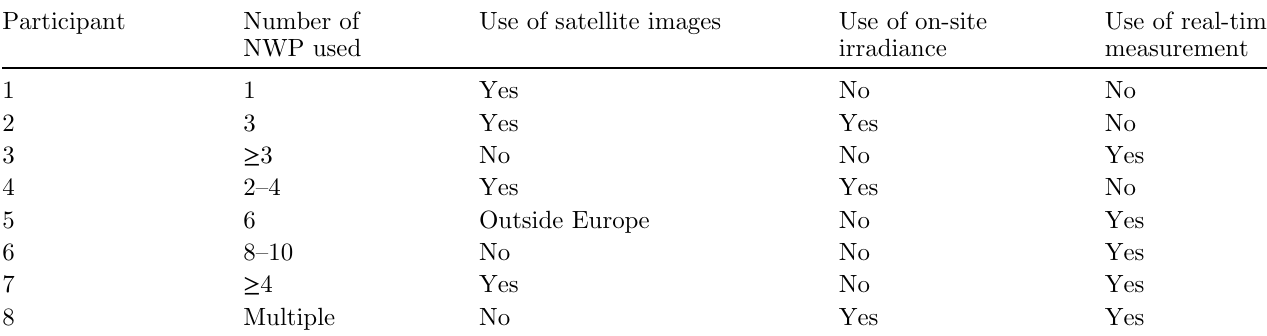
Table 2. Information given by the participants on their algorithms.